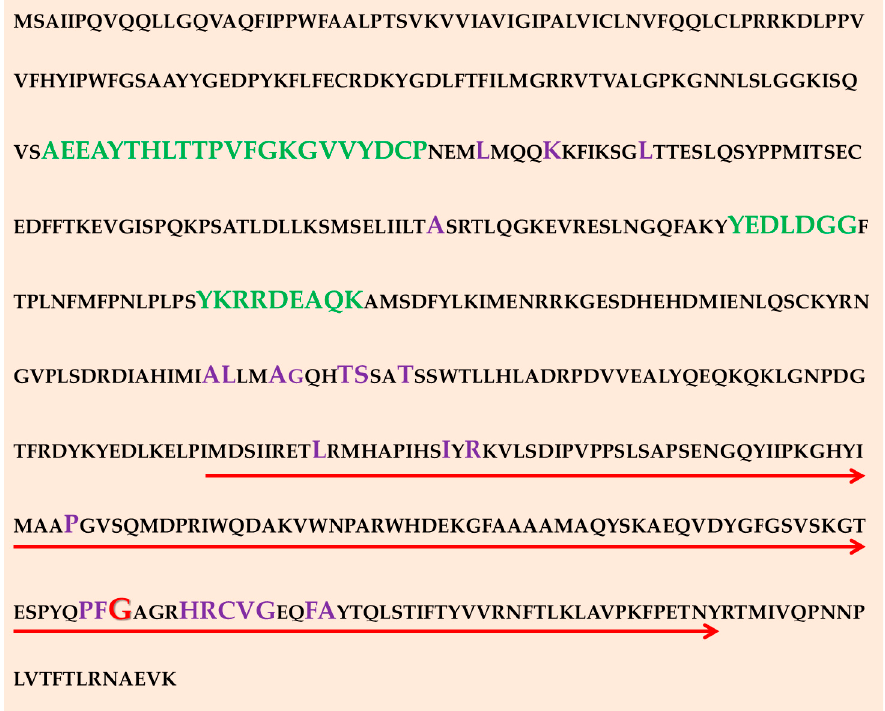
Figure 2. Amino acid sequence of the C.neorfomans ERG11 gene coding sequence indicating the region sequenced in this study. Thered arrows show the gene region which was sequenced that covers the “hotspot” region at position 484 (indicated red) previously associated with azole resistance [32]. Heme binding sites are highlighted in purple [20]. Substrate recognition sites are highlighted in green [33].